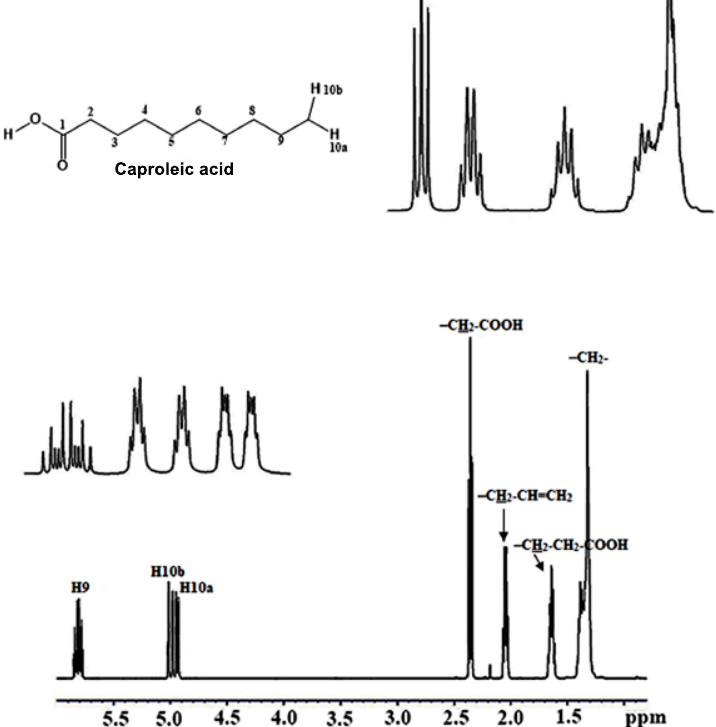
Figure 14. 500 MHz 1D 1 H-NMR spectrum of caproleic acid in CDCl 3 (concentration: 5 mM, T: 298 K, acquisition time: 2.7 s, relaxation delay: 8 s, number of scans: 128, experimental time: ~23 min).